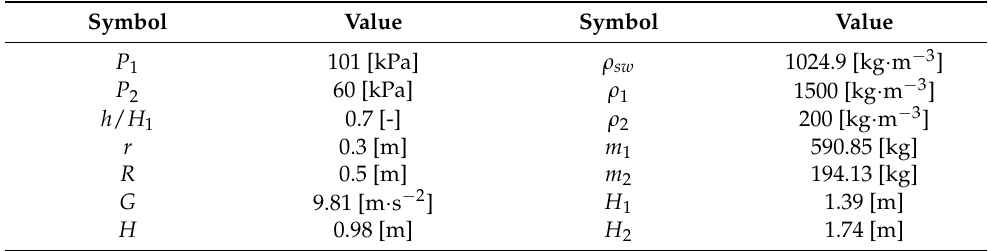
Table 3. Design parameters for WEC of